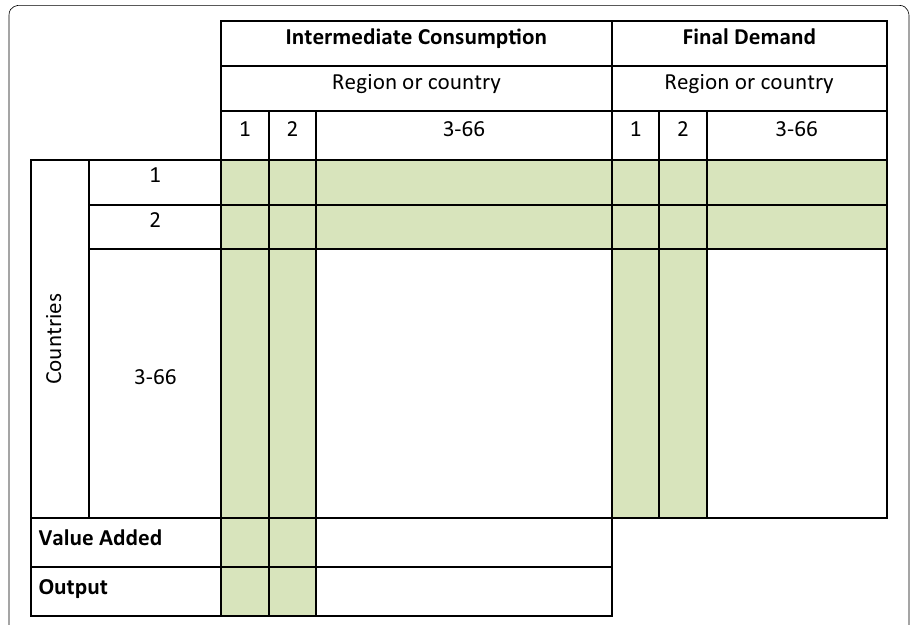
Fig. 2 The augmented MRIO table source: own elaboration. Bogotá is region 1, RoC is region